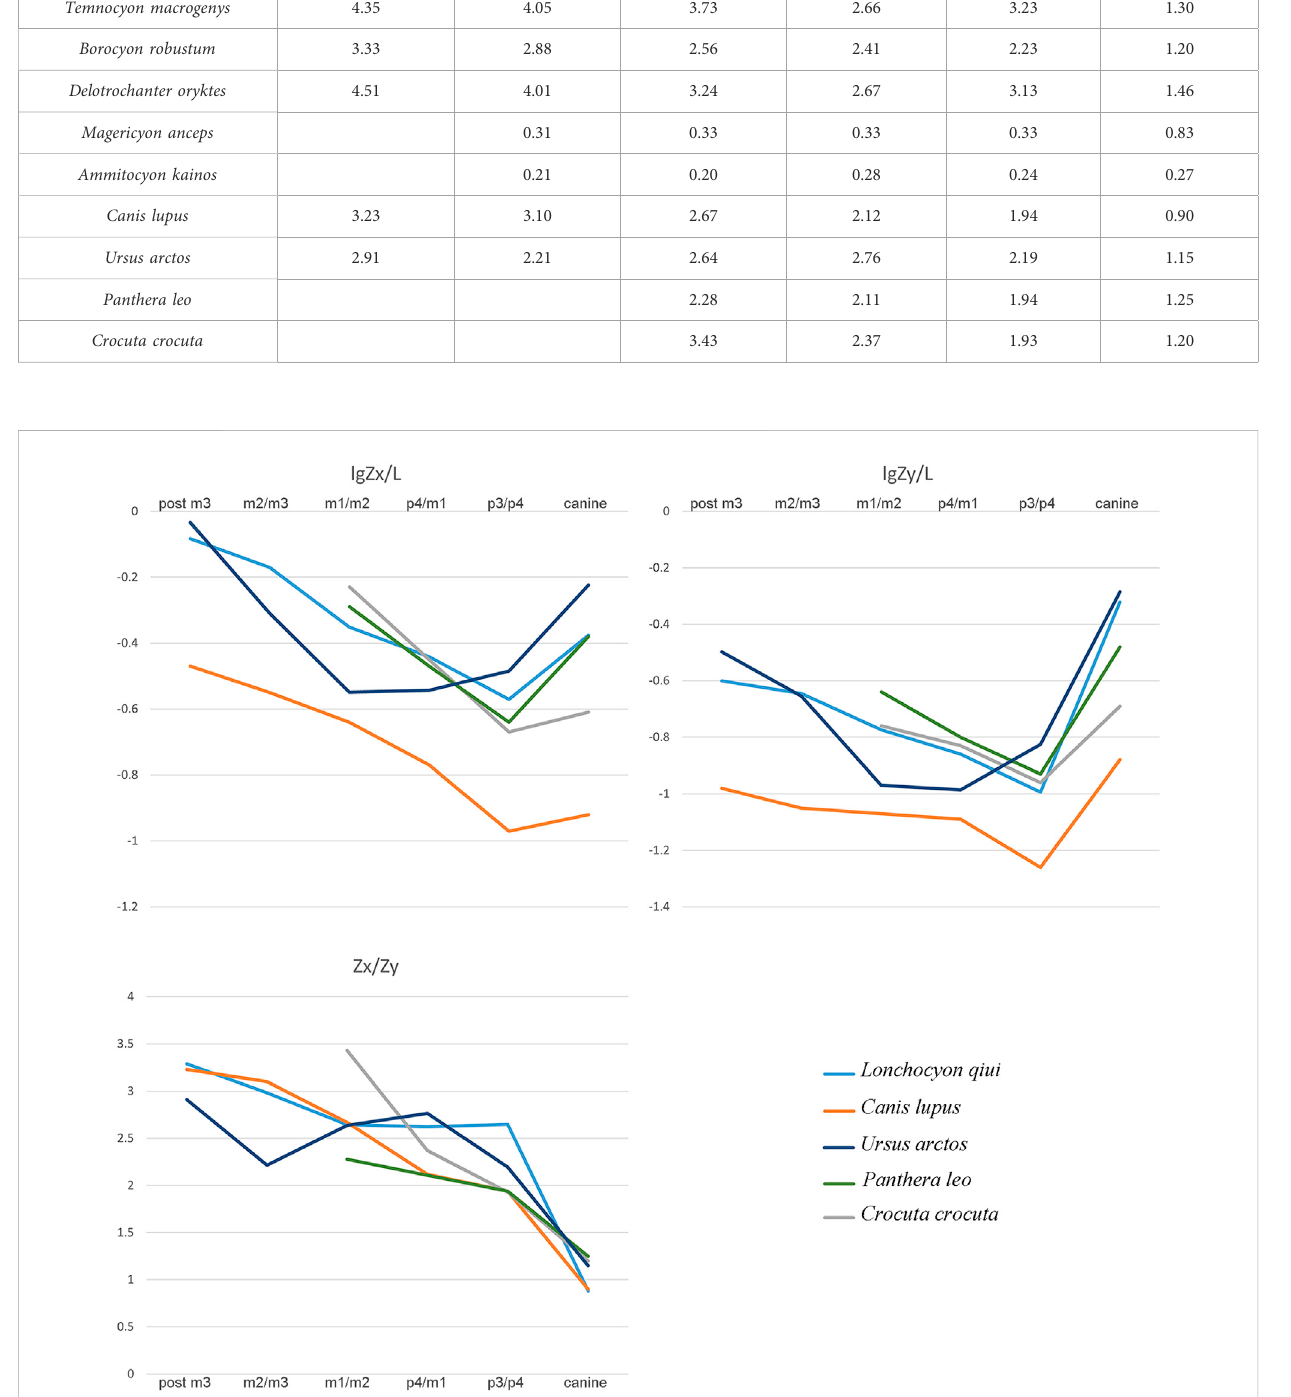
Frontiers in Earth